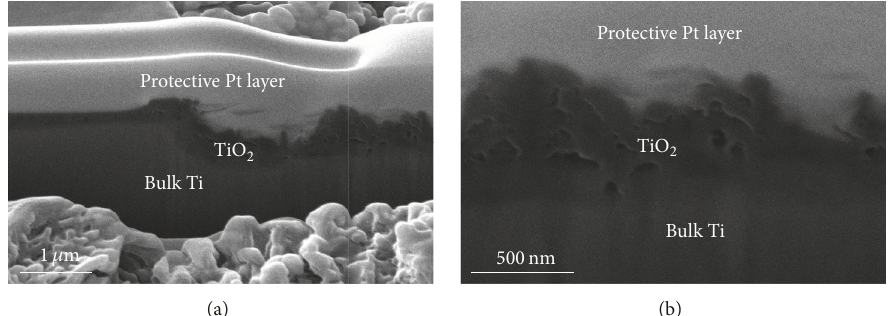
Figure 2: Focused ion beam (FIB) cross-sectional view of the Ep+An implant